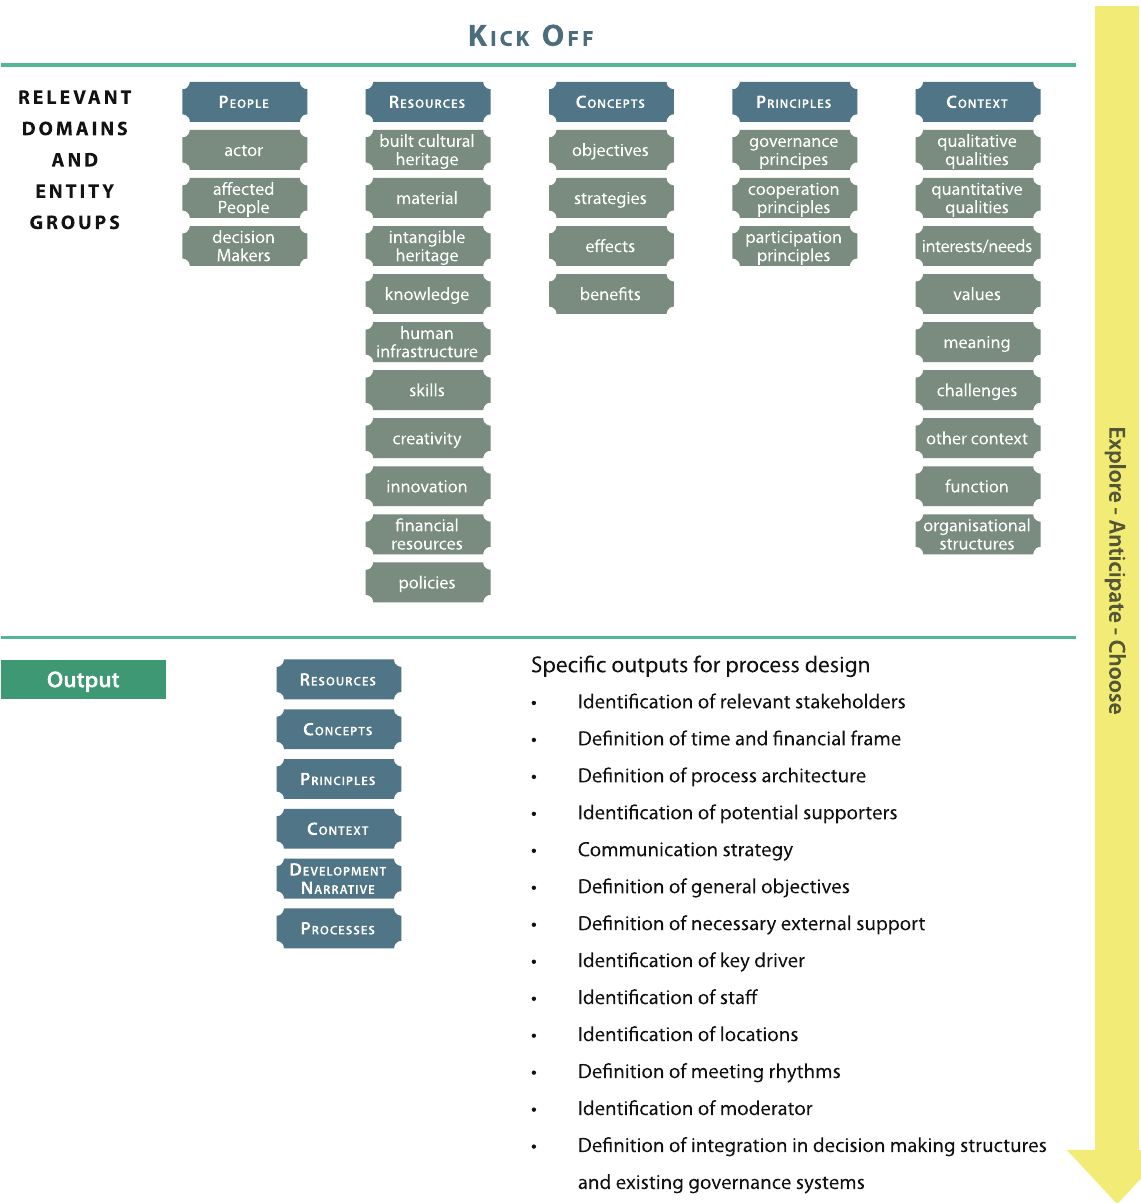
Fig. 7 The scoping phase of heritage-based urban development is used to prepare the entire process (Source: Ripp